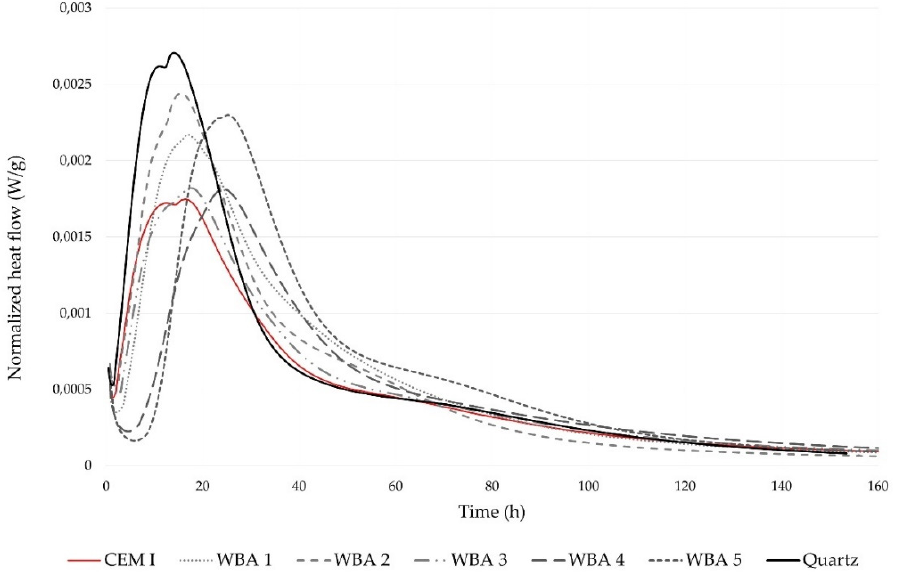
Figure 4. Heat flow of the reference paste (CEM I) without substitution, pastes with 15 wt% WBA, and paste with 15 wt% quartz, obtained by isothermal calorimetry.